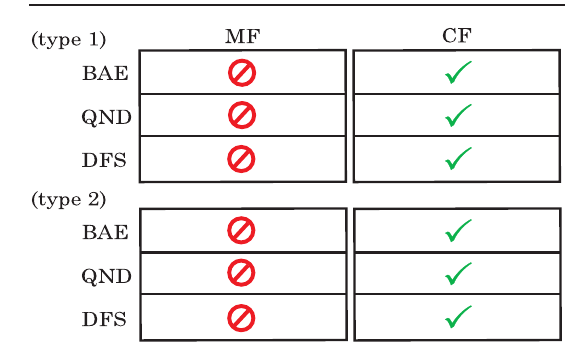
TABLE I. The no-go theorems (left column). For both “ types ” of control configurations, no MF controller can achieve the control goals; i.e. realization of BAE measurement, generation of a QND variable, and generation of a DFS. On the other hand, we find a CF controller achieving the task (right column) in every